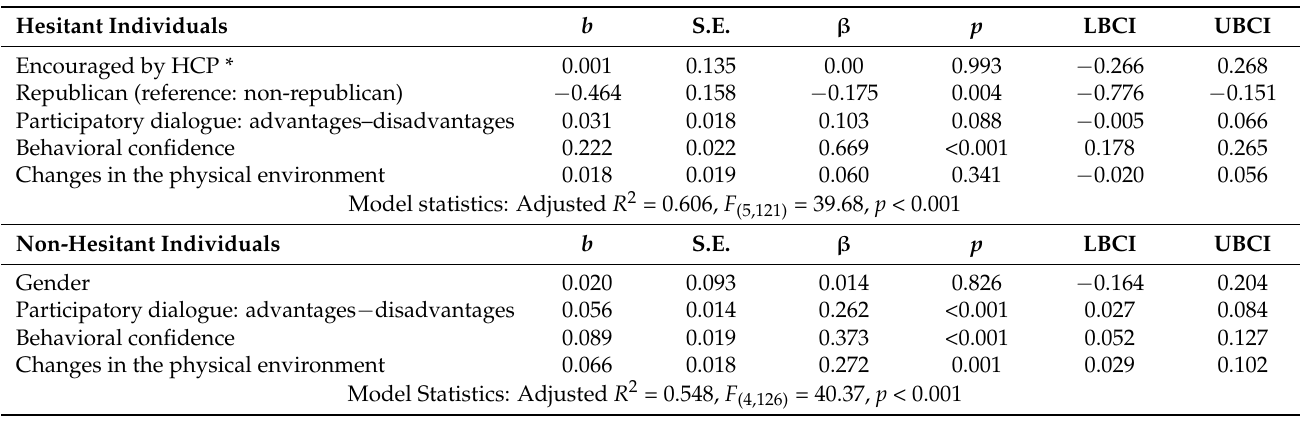
Table 4. Multiple regression models for Initiation of vaccination among hesitant and non-hesitant